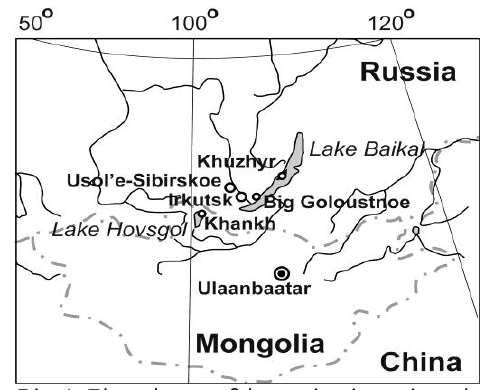
Fig. 1. The scheme of the region